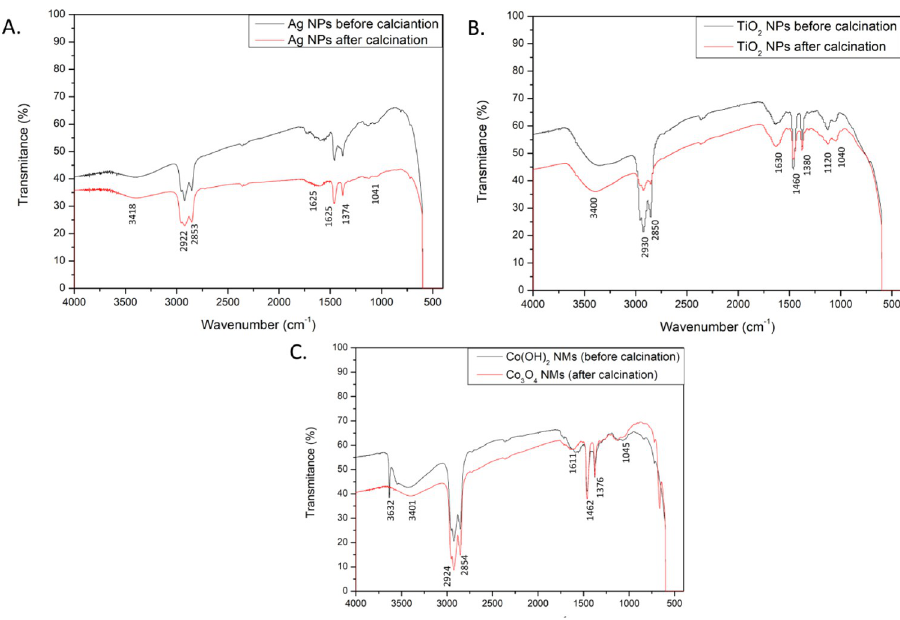
Fig 3. FTIR spectra of the prepared nanomaterials. (A) Ag NPs before and after calcination, (B) TIO2 NPs before and after calcination, (C) Co(OH)2 NMs and Co3O4 NMs.